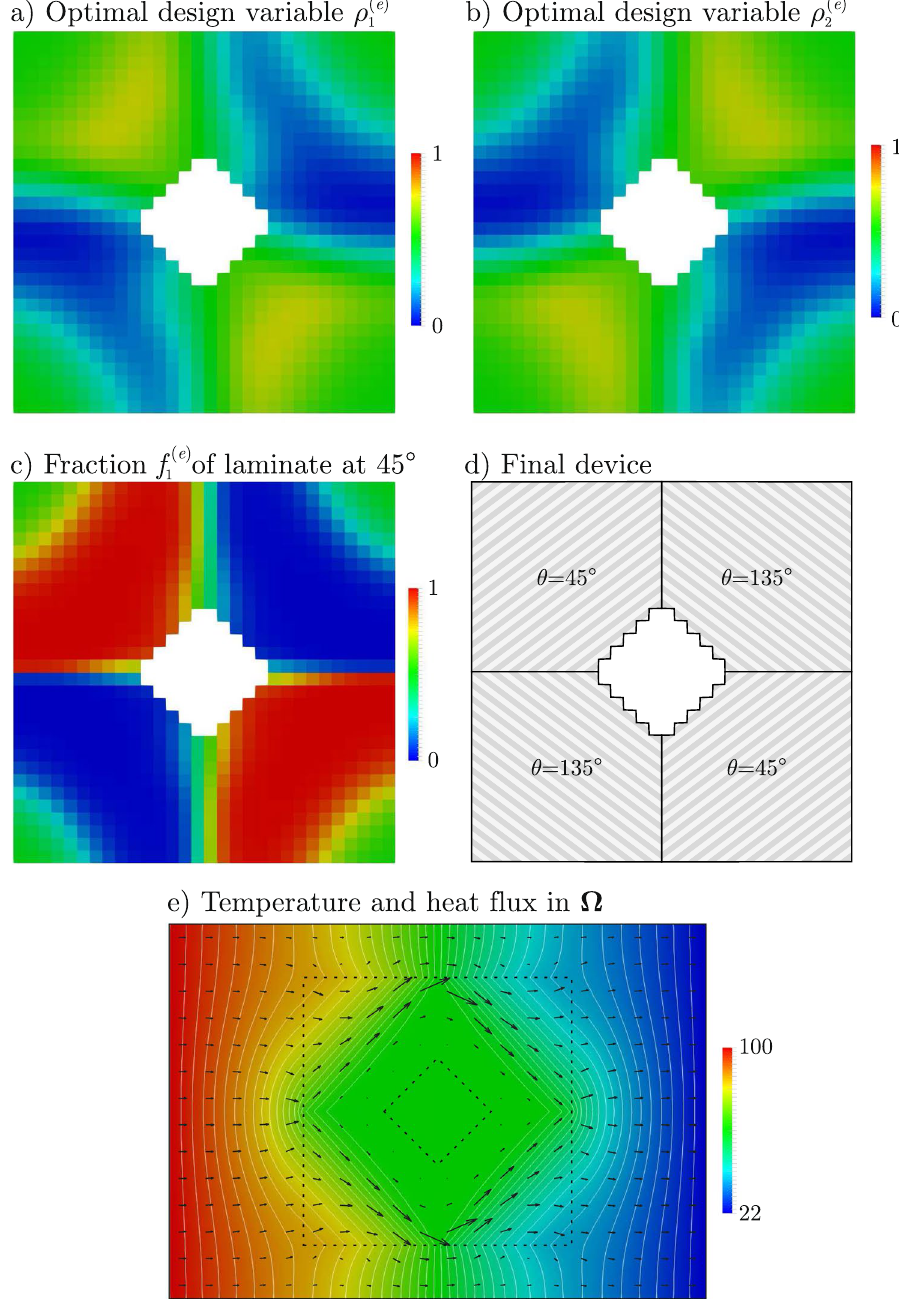
Figure 3. Validation example: ( a ) optimal design variable ρ e 1( ) , ( b ) optimal design variable ρ e 2( ) , ( c ) fraction of laminate at 45° for optimal ρ e 1( ) and ρ e 2( ) , ( d ) actual device, ( e ) temperature (colormap with isolines every 2 °C) and heat flux (arrows) in the whole